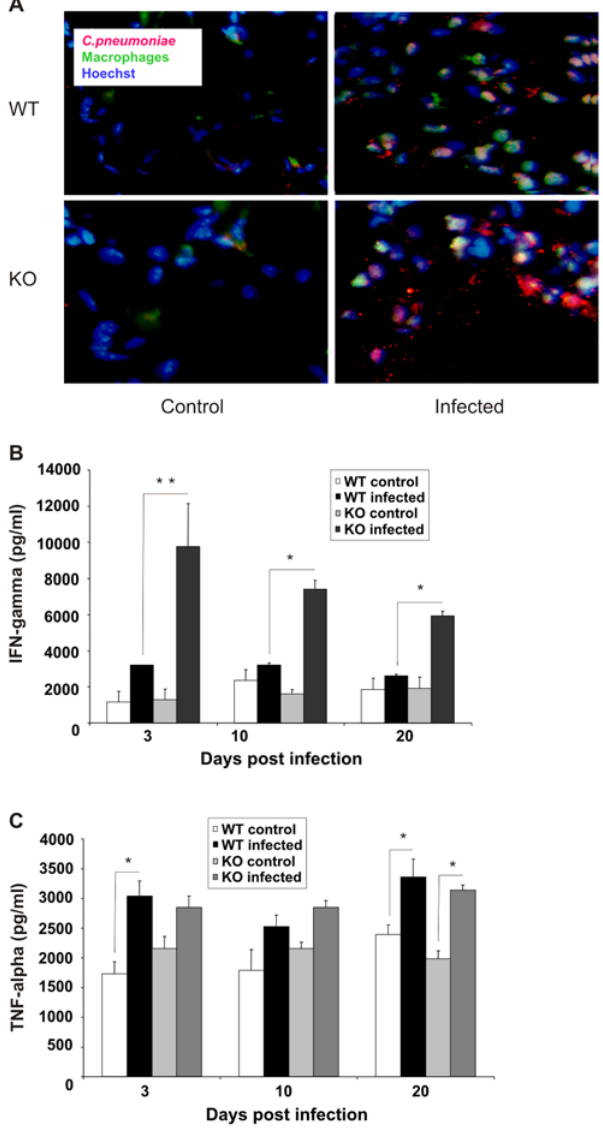
Figure 2. Dysregulated inflammatory responses of cIAP-1 KO mice. A. Reduced numbers of macrophages in lungs of infected cIAP-1 KO mice. The lungs from mice either non-infected or infected for 20 days were excised aseptically and 5 mm pieces were fixed and sectioned. The sections were stained with rabbit anti- Chlamydia LPS antibody and Cy3-conjugated secondary antibody, and with anti-CD68 antibody detected with Alexa-488 conjugated secondary antibody to localize C. pneumoniae and alveolar macrophages, respectively. The lung epithelial cells were stained with Hoechst and examined microscopically by using a fluorescent microscope under 40 6 of objective. The figure shows a typical example of at least five independent infections. B, C. Levels of IFN- c (B) and TNF- a (C) were determined in lung homogenates from wildtype and cIAP-1 KO mice by ELISA at different time points post infection. Data represent the mean 6 SEM from five independent infection experiments. * p # 0.05; ** p #